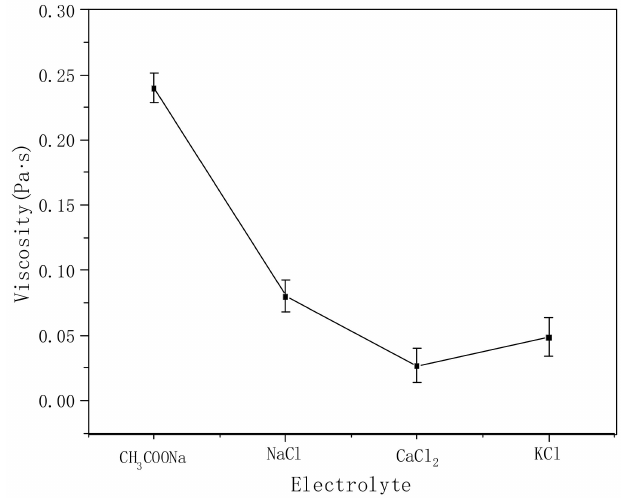
Figure 8. Effects of different electrolytes on the viscosity of polymer aqueous solution (polymer concentration: 0.3%, electrolyte concentration: 0.001 mol/L).